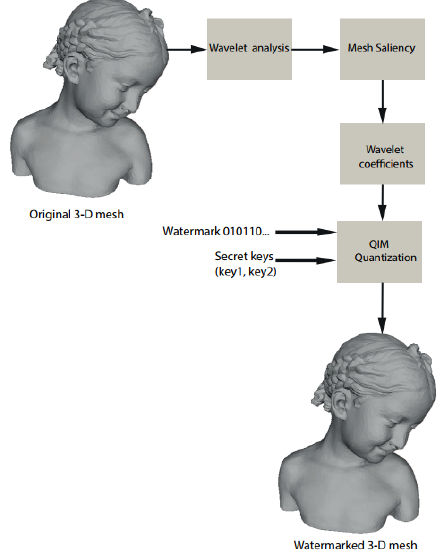
Figure 4. The proposed embedding scheme.